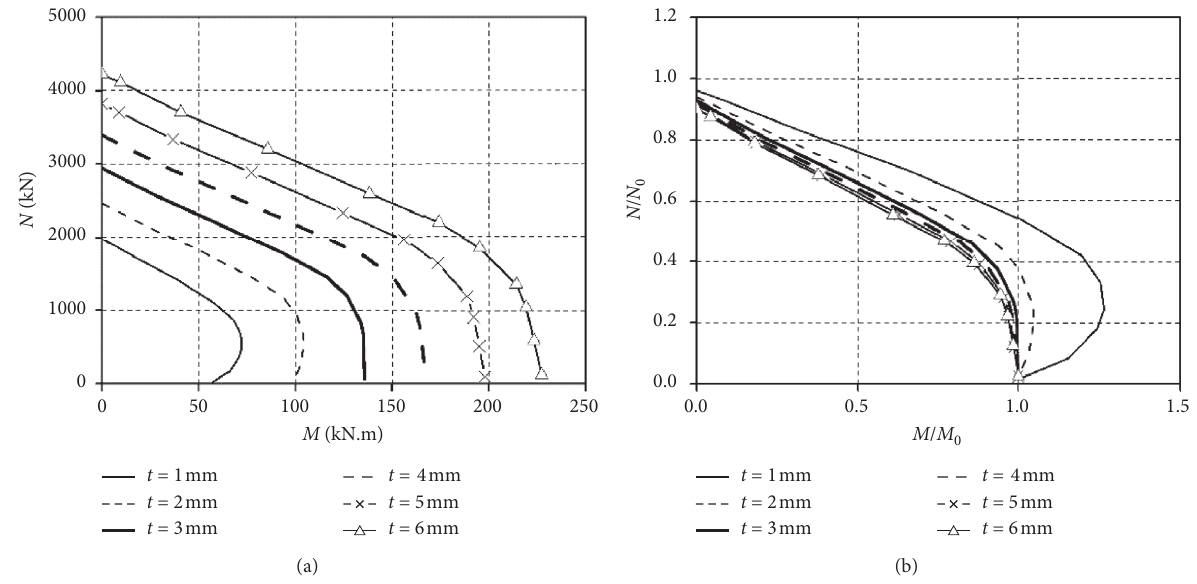
Figure 15: Influence of steel tube thickness t on the component-based resistance correlation curves. (a) Slenderness ratio of 20. (b) Slenderness ratio of 20 (normalized).